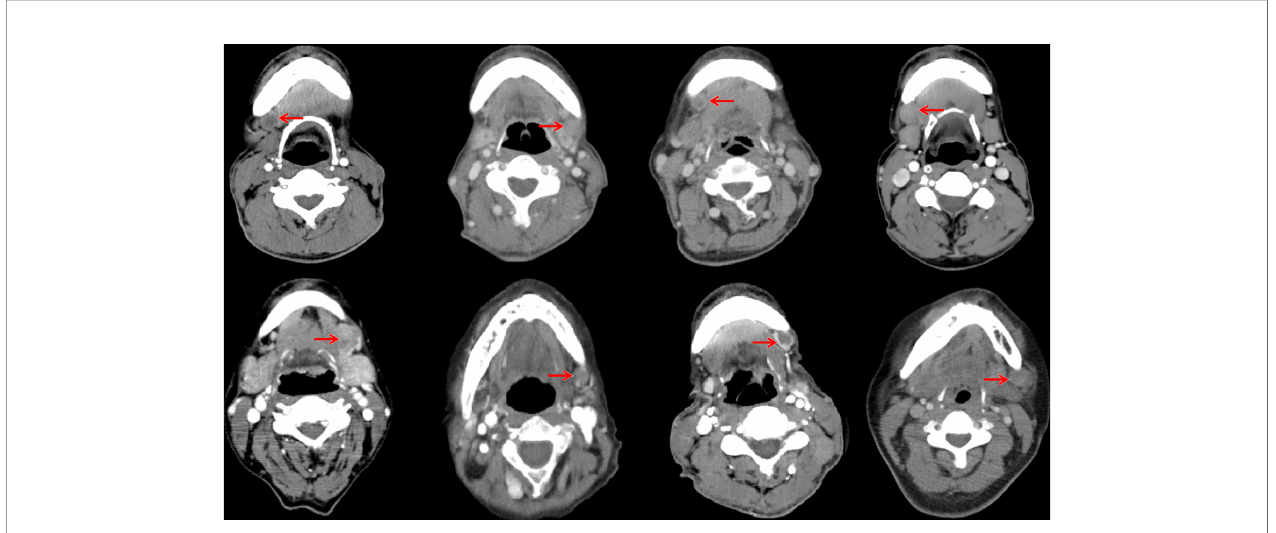
FIGURE 4 | Computed tomography axial images from patients with lymphadenopathy in level IB (red arrow, lymphadenopathy in level IB).